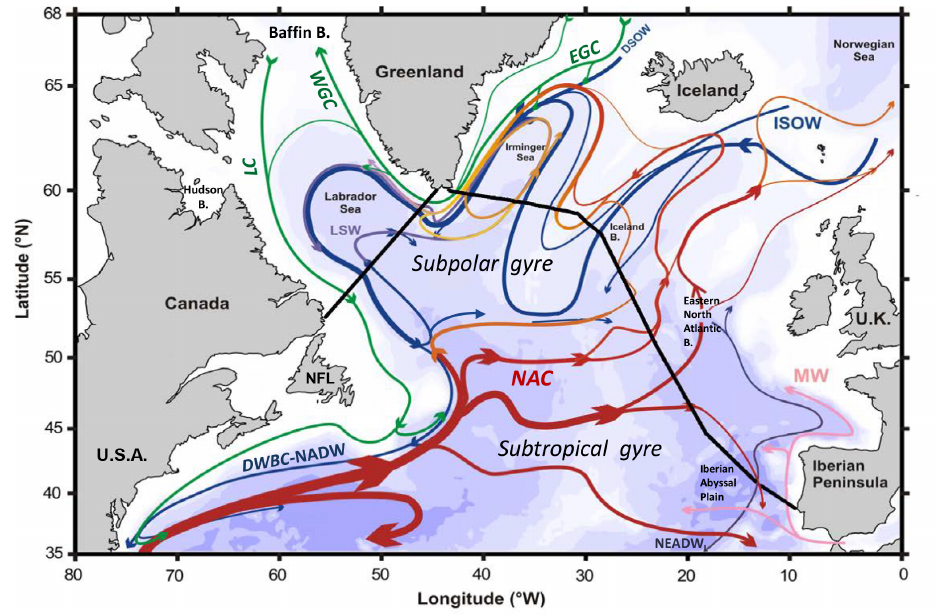
Figure 1. Schematic view of the water circulation in the North Atlantic Ocean adapted from García-Ibáñez et al. (2015) and Daniault et al. (2016). Red lines indicate the circulation in surface, while blue lines indicated circulation at depth. Black lines represent the G EOVIDE cruise that transects (G EOTRACES -GA01). The main geographical features, water masses and currents are indicated: Newfoundland (NFL), United Kingdom (UK), United States of America (USA), Denmark Straight Overflow Water (DSOW), Iceland–Scotland Overflow water (ISOW), Labrador Sea Water (LSW), Lower North East Atlantic Deep Water (NEADW L ) , Mediterranean waters (MW) and North Atlantic Deep Water (NADW), Deep Western Boundary Current (DWBC), East Greenland Current (EGC), Labrador Current (LC), North Atlantic Current (NAC) and West Greenland Current